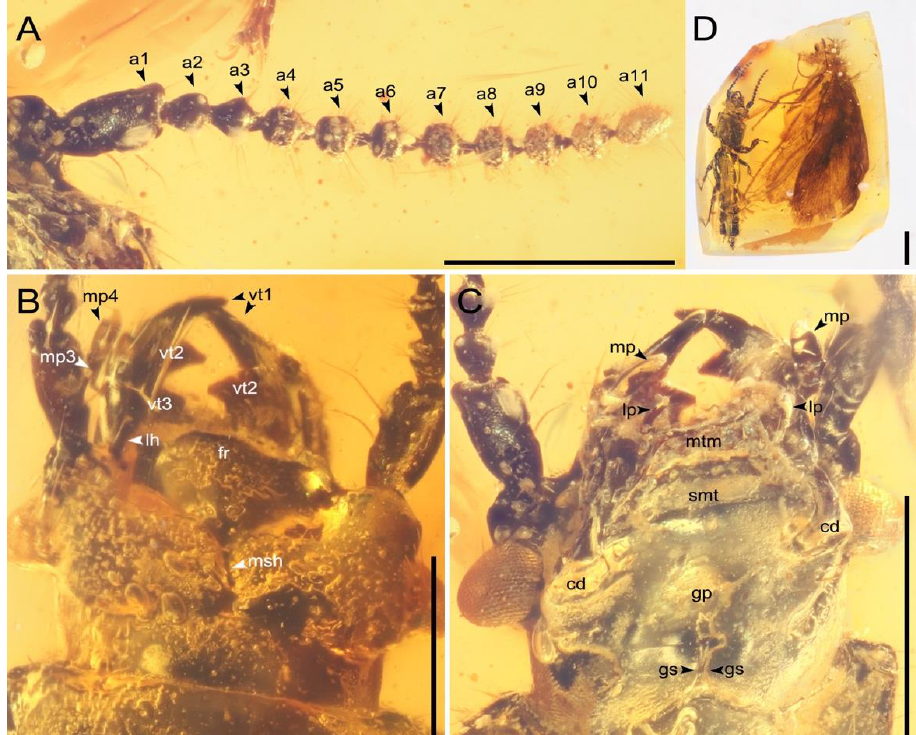
Figure 2. Entire amber piece with holotype and detailed of head of Priochirus trisclerite sp. nov., holotype, QUST-SHUO-0003. ( A ) Right antenna, ventral view. ( B ) Head, dorsal view. ( C ) Head, ventral view. ( D ) Piece of amber with holotype (trichopteran syninclusion at right). Abbreviations: a1 – 11, antennomeres; cd, cardo of maxilla; fr, frons; gp, gular plate; gs, gular suture; lh, lateral horn of head; lp, labial palpus; mp, maxillary palpus; mp3 – 4, maxillary palpomeres; msh, median longitudinal sulcus; mtm, mentum; smt, submentum; vt1–3, ventral teeth of mandible. Scale bars for ( A – C ) = 0.5 mm; ( D ) = 1 mm.